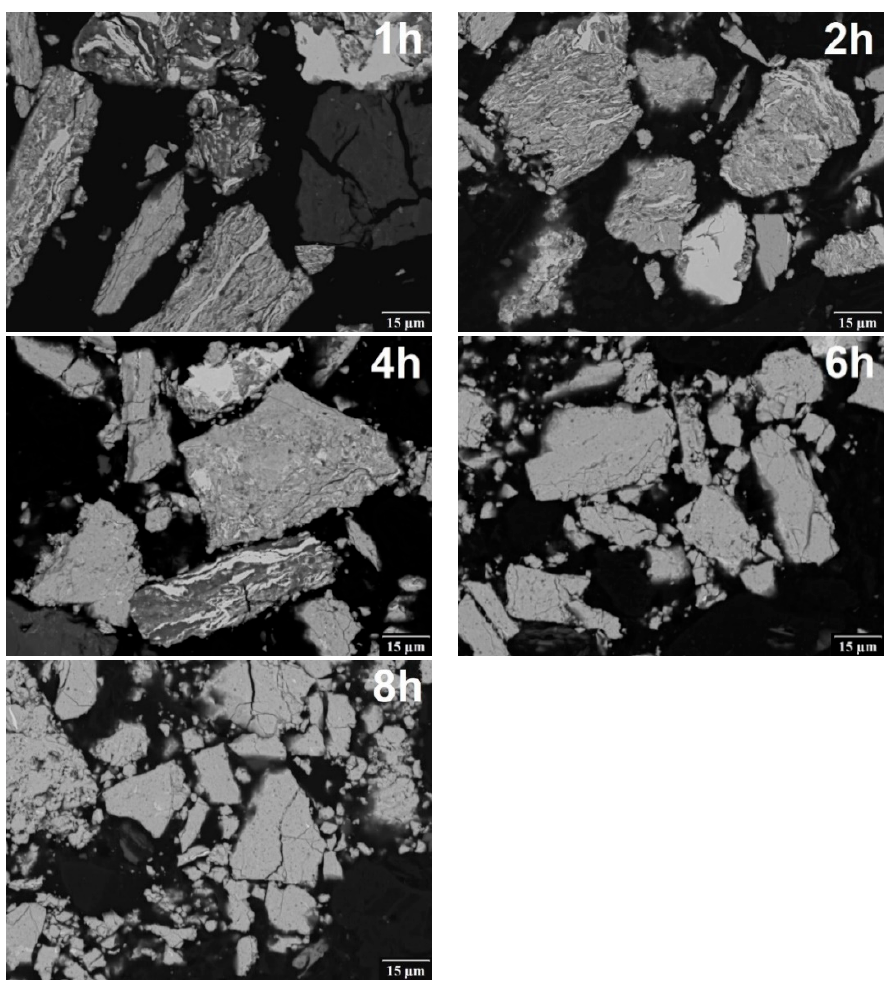
Figure 3. Typical example of the microstructure evolution with increasing time of mechanical alloying (Fe_AlSi powder mixture, SEM BSE micrographs).